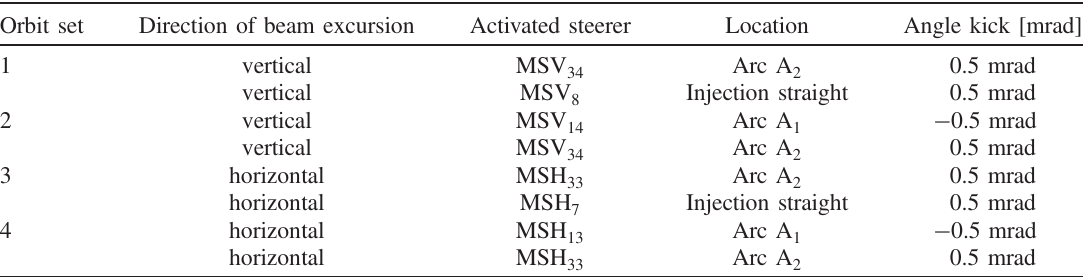
TABLE III. The four orbit sets 1,2,3,4 used for the simulations with COSY-I NFINITY to evaluate the sensitivity of different orbit settings on the spin-transfer parameters of the